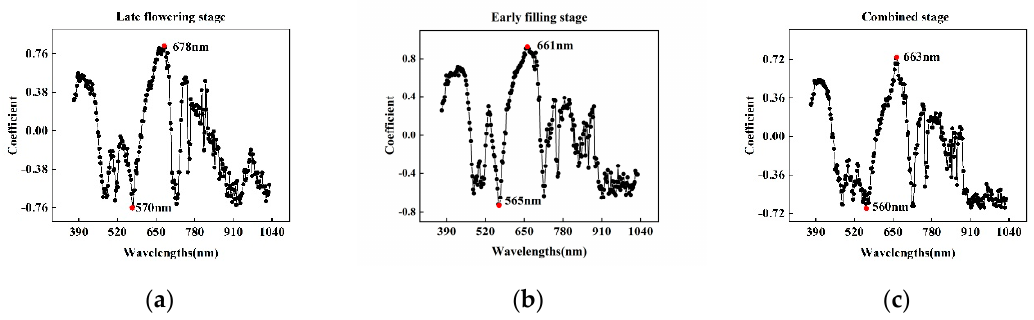
Figure 5. Weight coefficients calculated by RF at the late flowering stage ( a ), early filling stage ( b ) and Combined stage ( c ) .